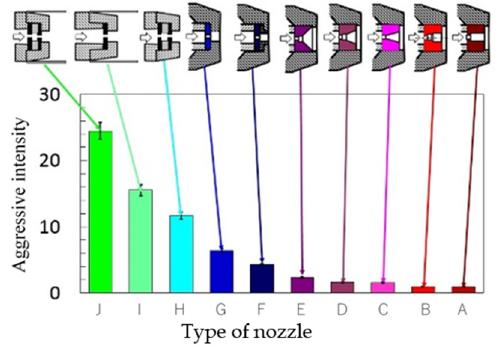
Figure 14. Schematic diagram of aggressive intensity of the cavitating jet using several types of nozzles.